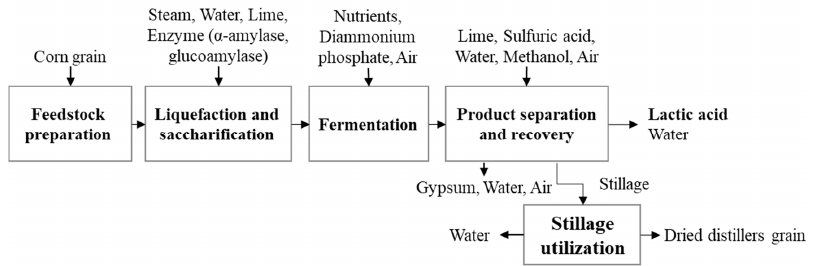
Figure 1. Overview of conversion steps of corn grain to lactic acid.